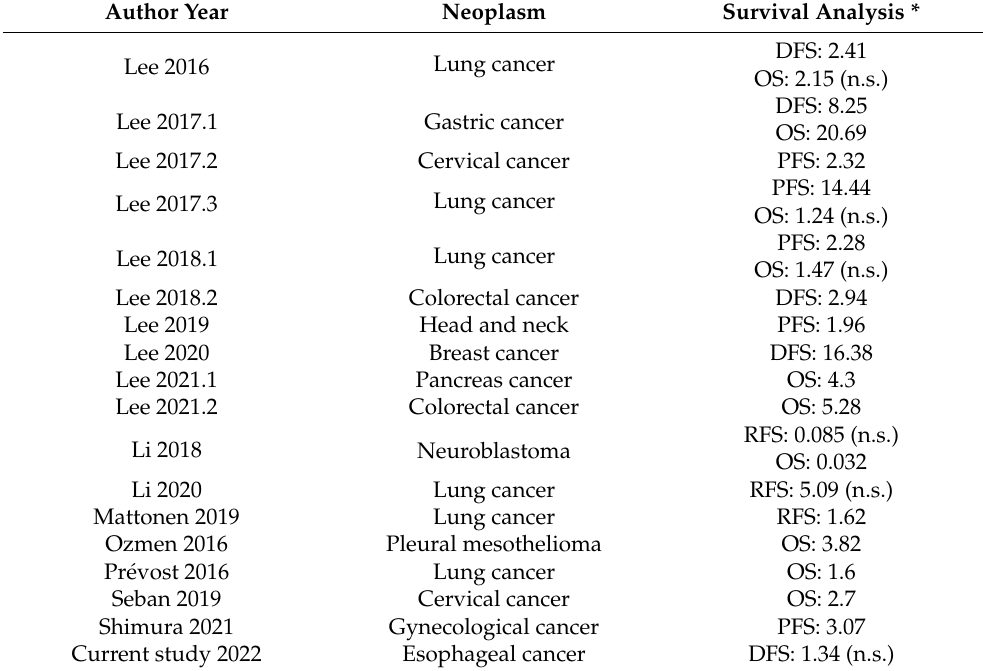
Table 6. Summary of the survival outcomes in the included studies. * Survival analyses were expressed as hazard ratio from multivariate models of FDG bone marrow uptake association with survival. Gray hatched outcomes show statistical significant association. OS: Overall survival; PFR: Progression-free survival; DFS: Disease-free survival. n.s.: Non significant association. Author Year